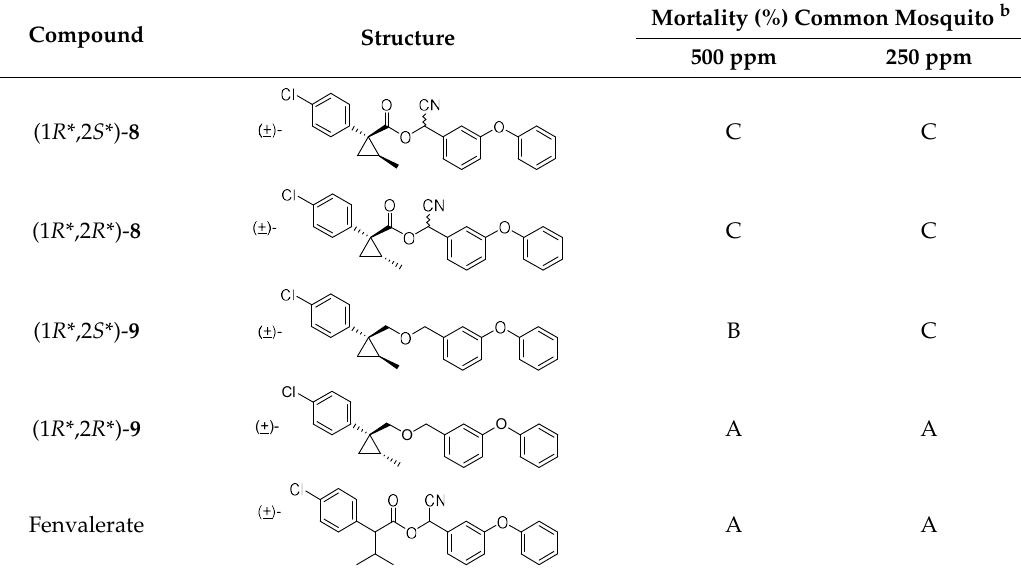
Table 2. Insecticidal activity of achiral cyanohydrin esters (1 R *,2 S *)- 8 , (1 R *,2 R *)- 8 and achiral ethers